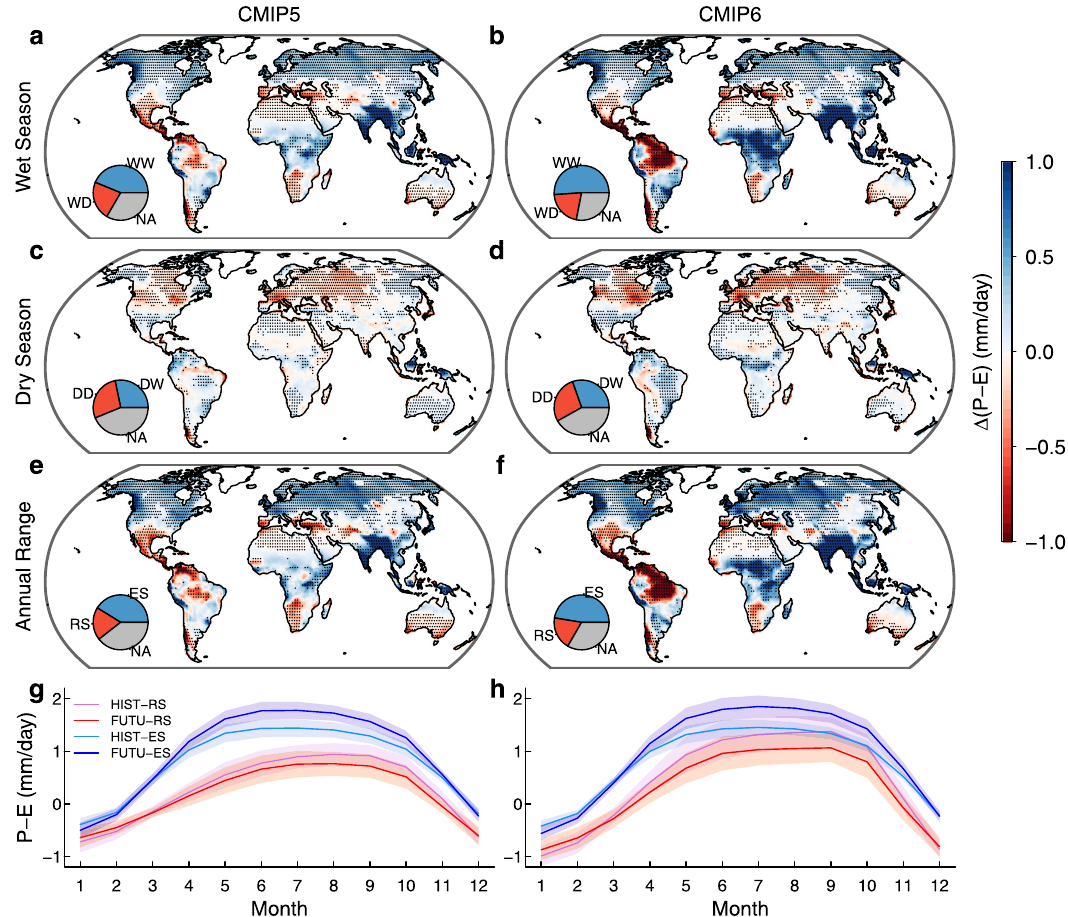
Fig. 1 | Multi – model mean seasonal changes in water availability in CMIP5